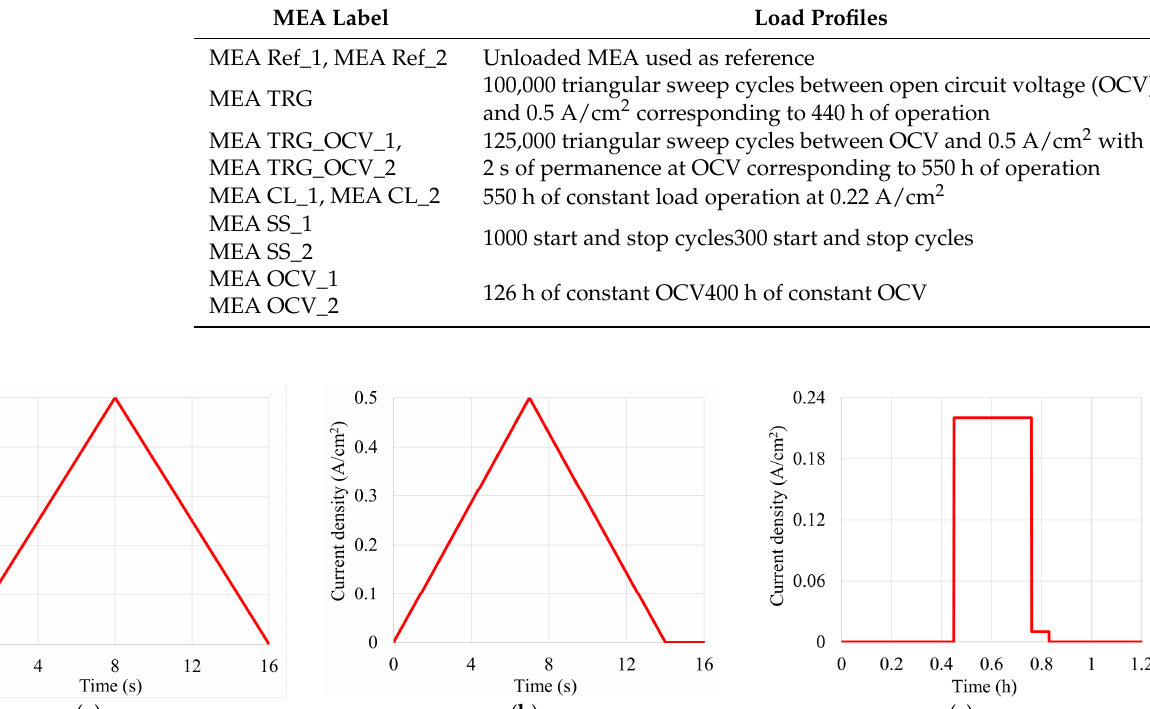
Table 1. Load profiles description of all membrane electrode assemblies (MEAs) (abbreviations: TRG: triangular sweep cycles, OCV: open circuit voltage, CL: constant load, SS: start and stop).